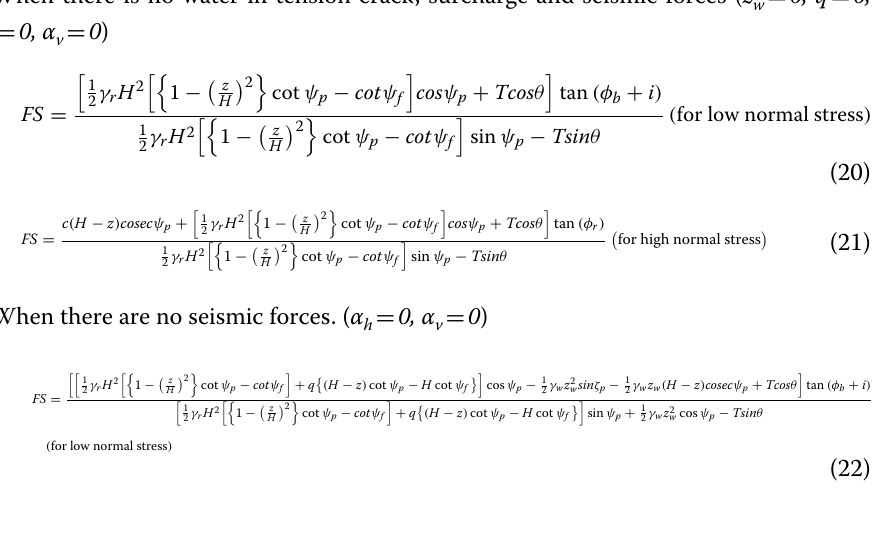
When there are no seismic forces. ( α h